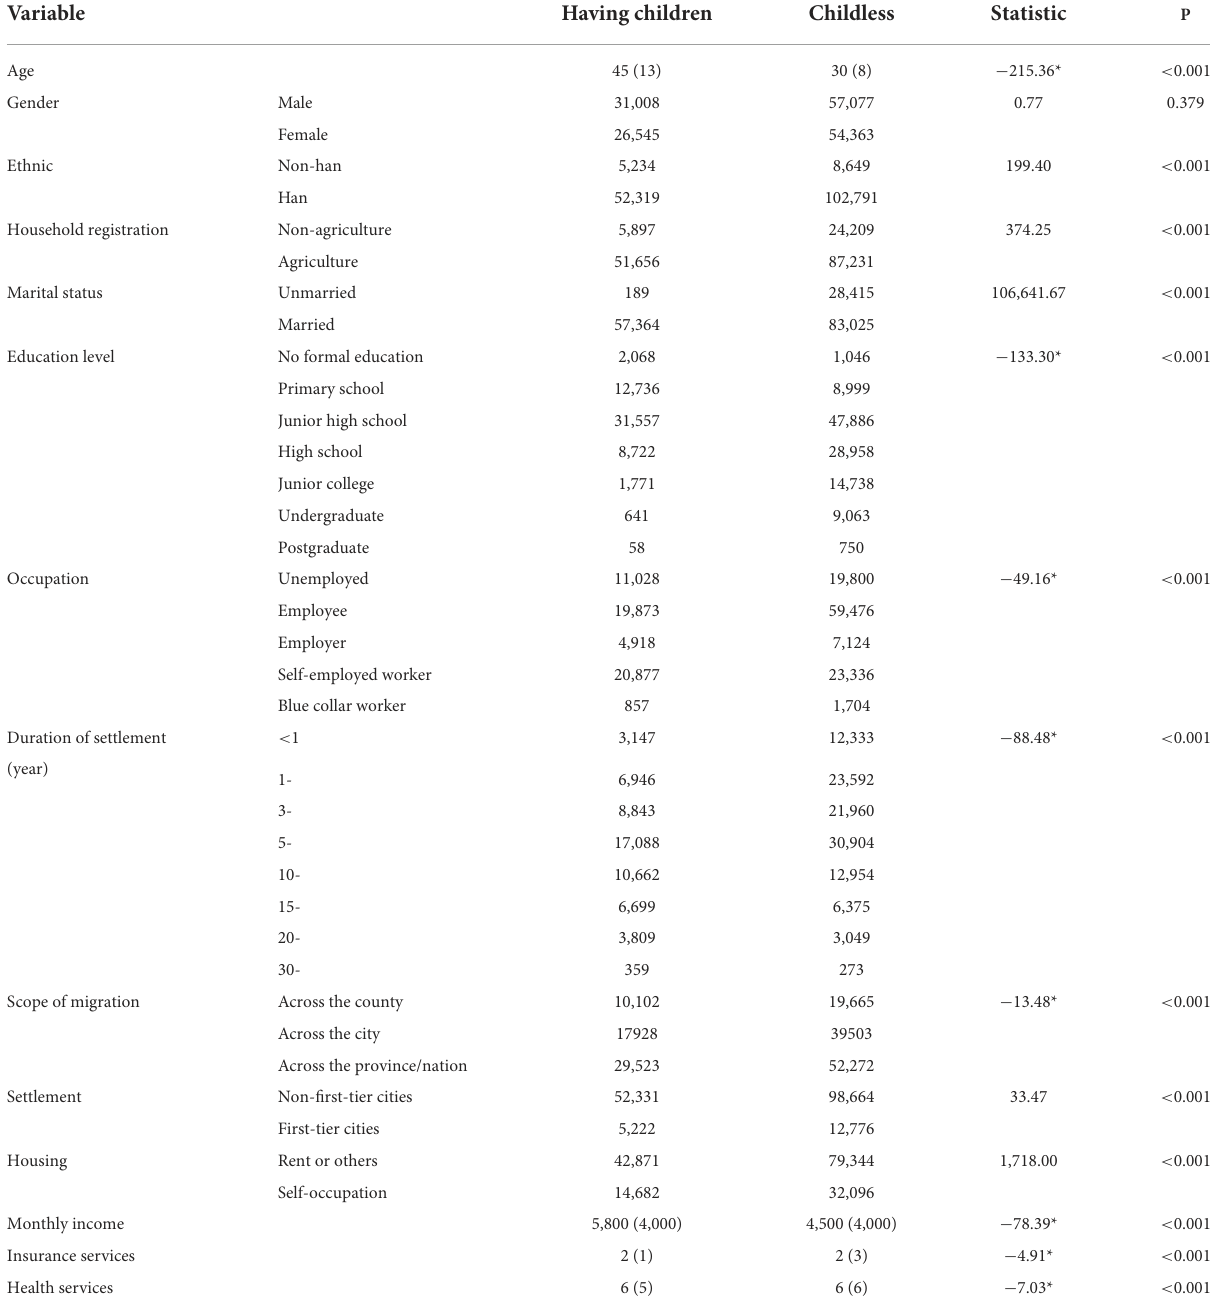
Variable Having children Childless